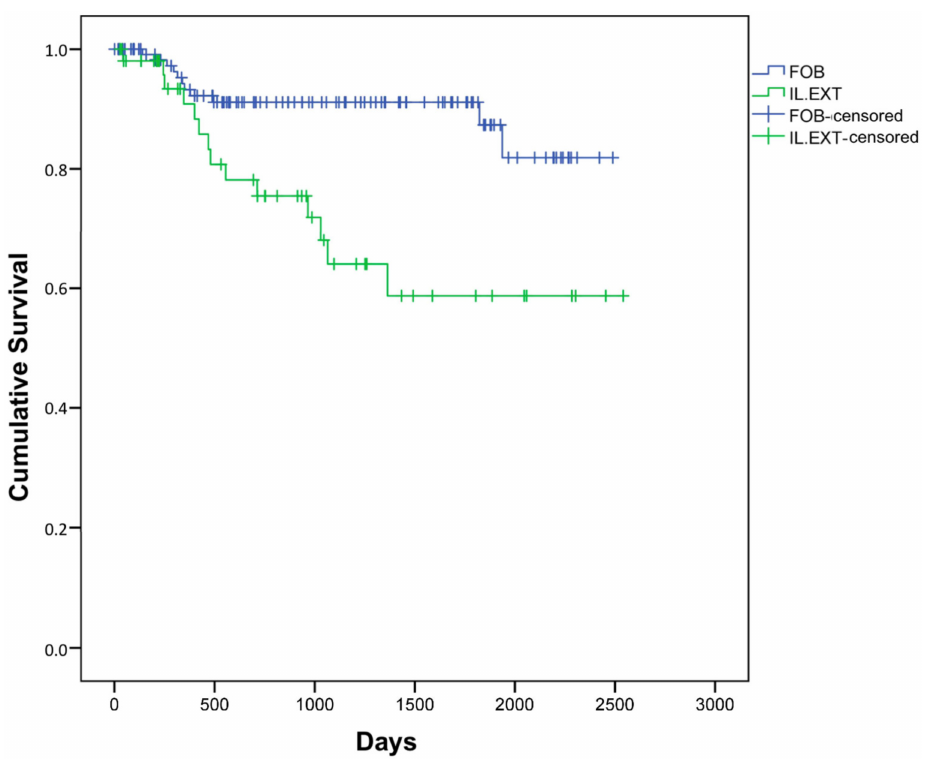
Figure 1. Kaplan–Meier estimate. Disease-free survival comparing sentinel node location (FOB: Obturator Fossa; IL. EXT: External Iliac Artery). Log-rank test p <